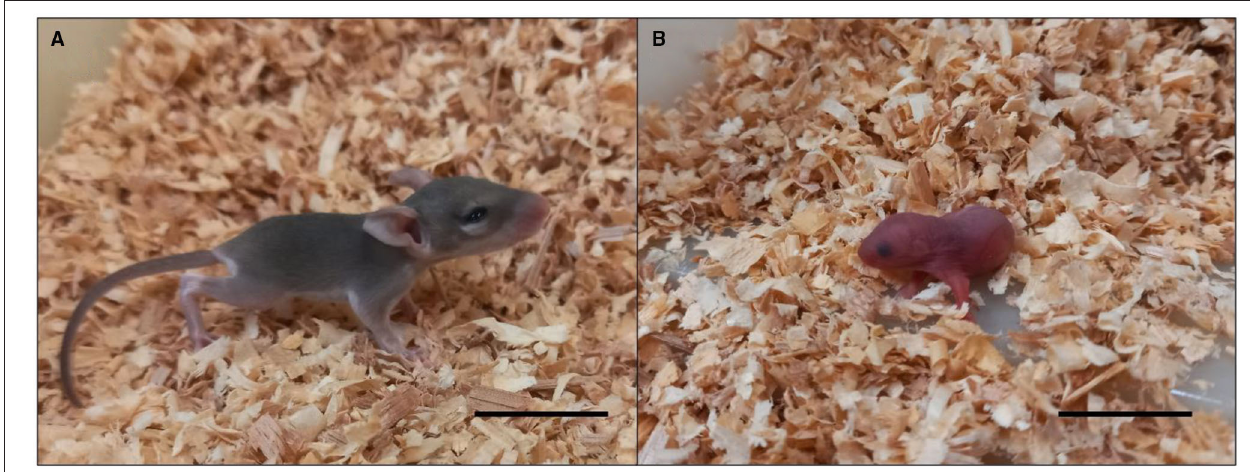
FIGURE 1 | Spiny mouse (A) and mouse (B) pups on the day of birth. Spiny mice are covered in fur, eyes and ears opened, mobile with limbs fully developed and functional, weighing ∼ 5–6g in litter sizes of 1–5. The mouse pup has not developed fur, or mobility, with eyes and ears closed. Mice weigh ∼ 1–2g in litter sizes of 4–12. Scale bars =